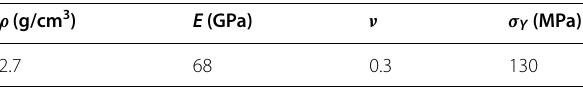
Table 3 Material properties used in manned airtight module of Section